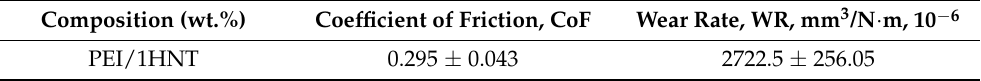
Table 7. The tribological properties of the PEI/1HNT nanocomposite. Point tribological contact. Composition (wt.%)